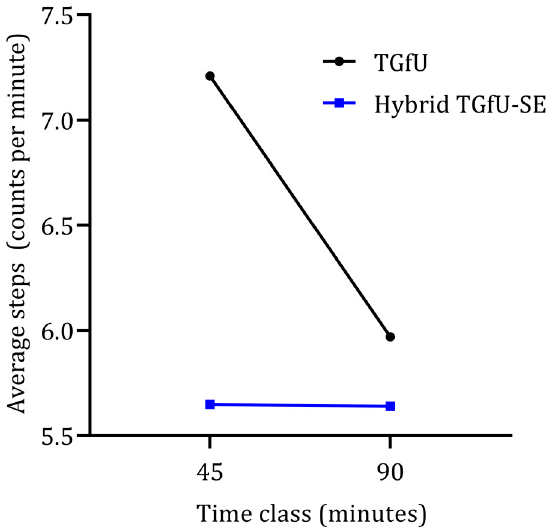
Figure 3. Average step count per minute variation from 45 min to 90 min classes considering two different pedagogical models (TGfU and hybrid TGfU-SE).